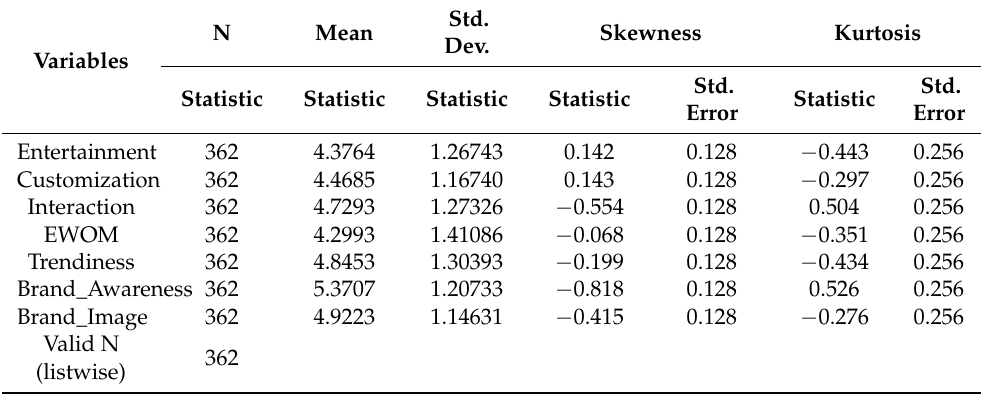
Table 2. Descriptive